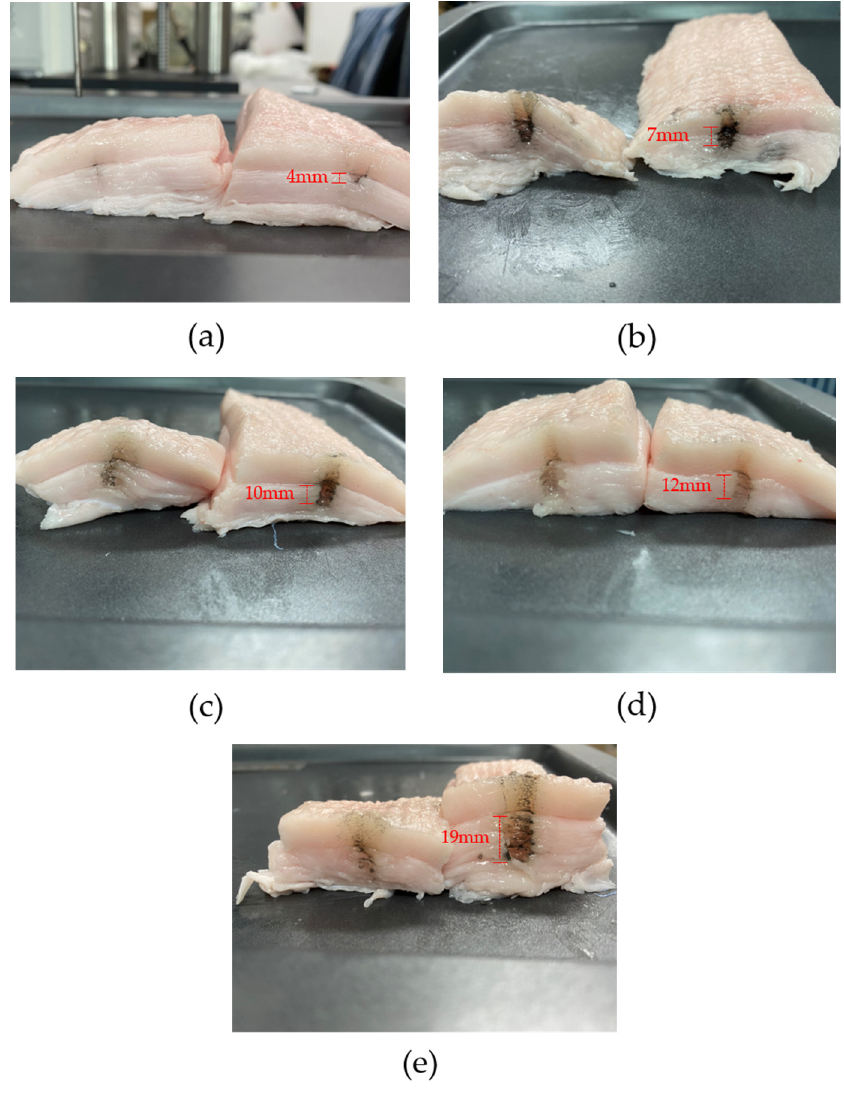
Figure 14. Heat damage afflicted by the transducer as a function of applied voltage: ( a ) 100 V pp , ( b )